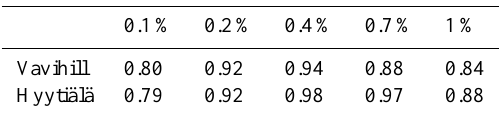
Fig. 1. Map showing the locations of the stations and the selected areas studied in the satellite images. Table 1. Correlation coefficients between CCN counter data at dif- ferent supersaturation and N 80